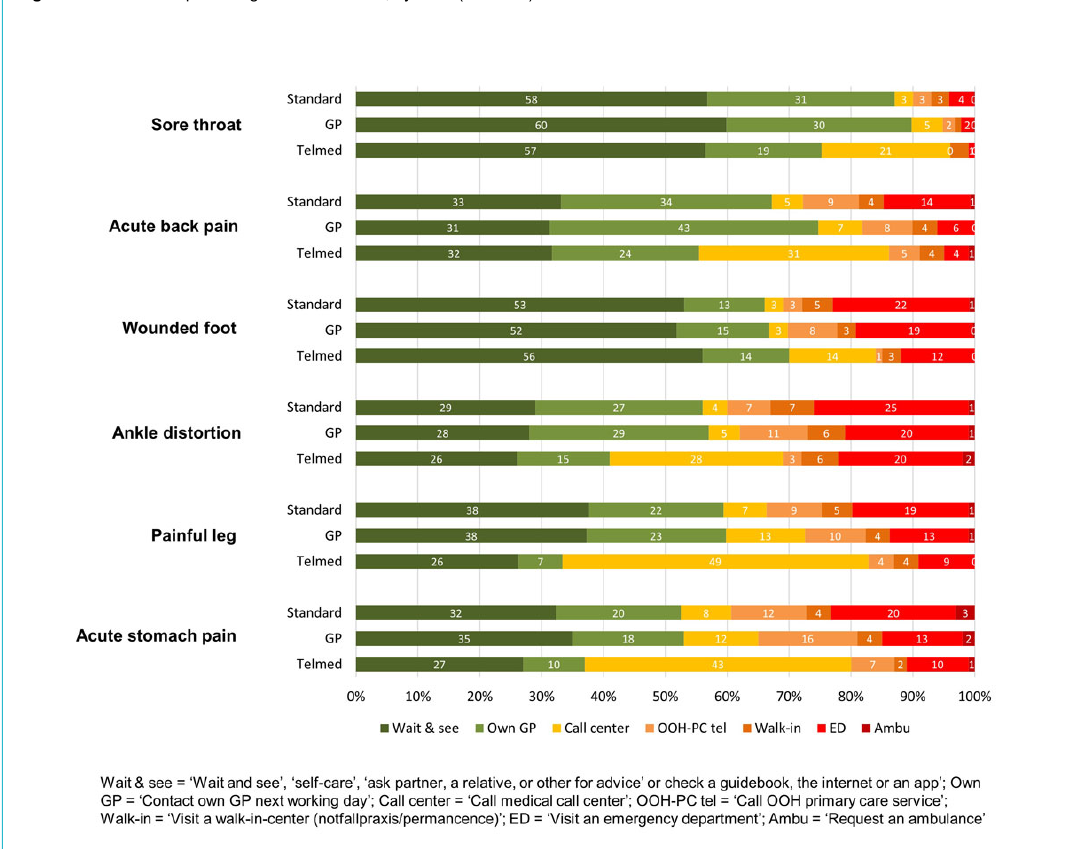
Figure 1: Intended help-seeking for the six cases, by HCP (n = 1126).